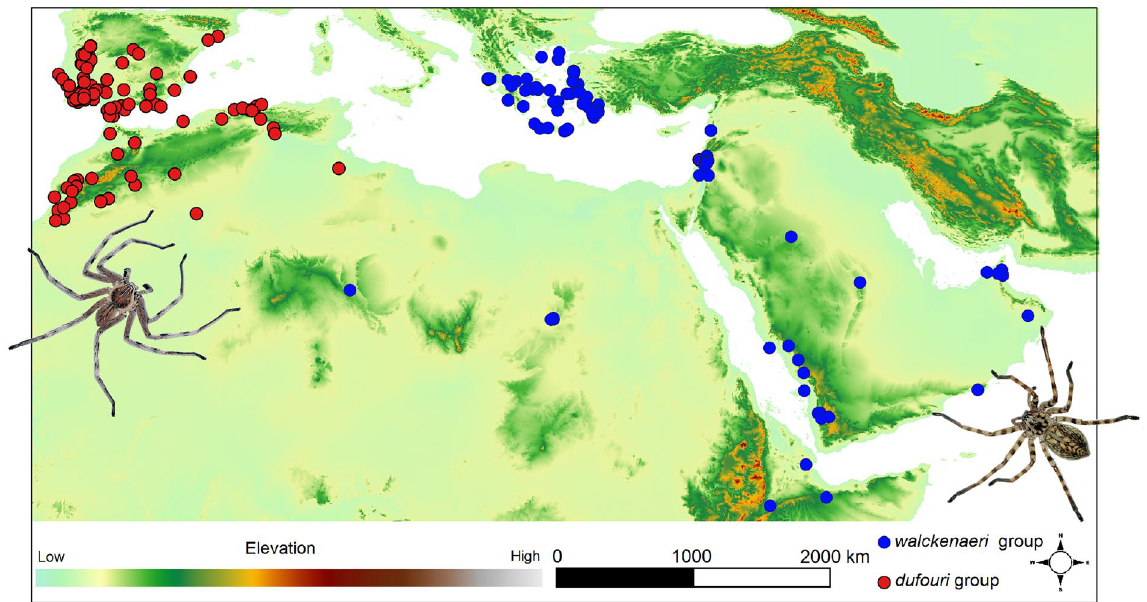
Figure 6. Distribution records of the dufouri clade and walckenaeri clade on a topographic overview of the study area. Elevation map was obtained from the Shuttle Radar Topography Mission (SRTM) elevation model (https:// srtm. csi. cgiar. org/) and mapped in QGIS 3.22.3 (https:// www. qgis. org). The spiders were photographed by Majid Moradmand.